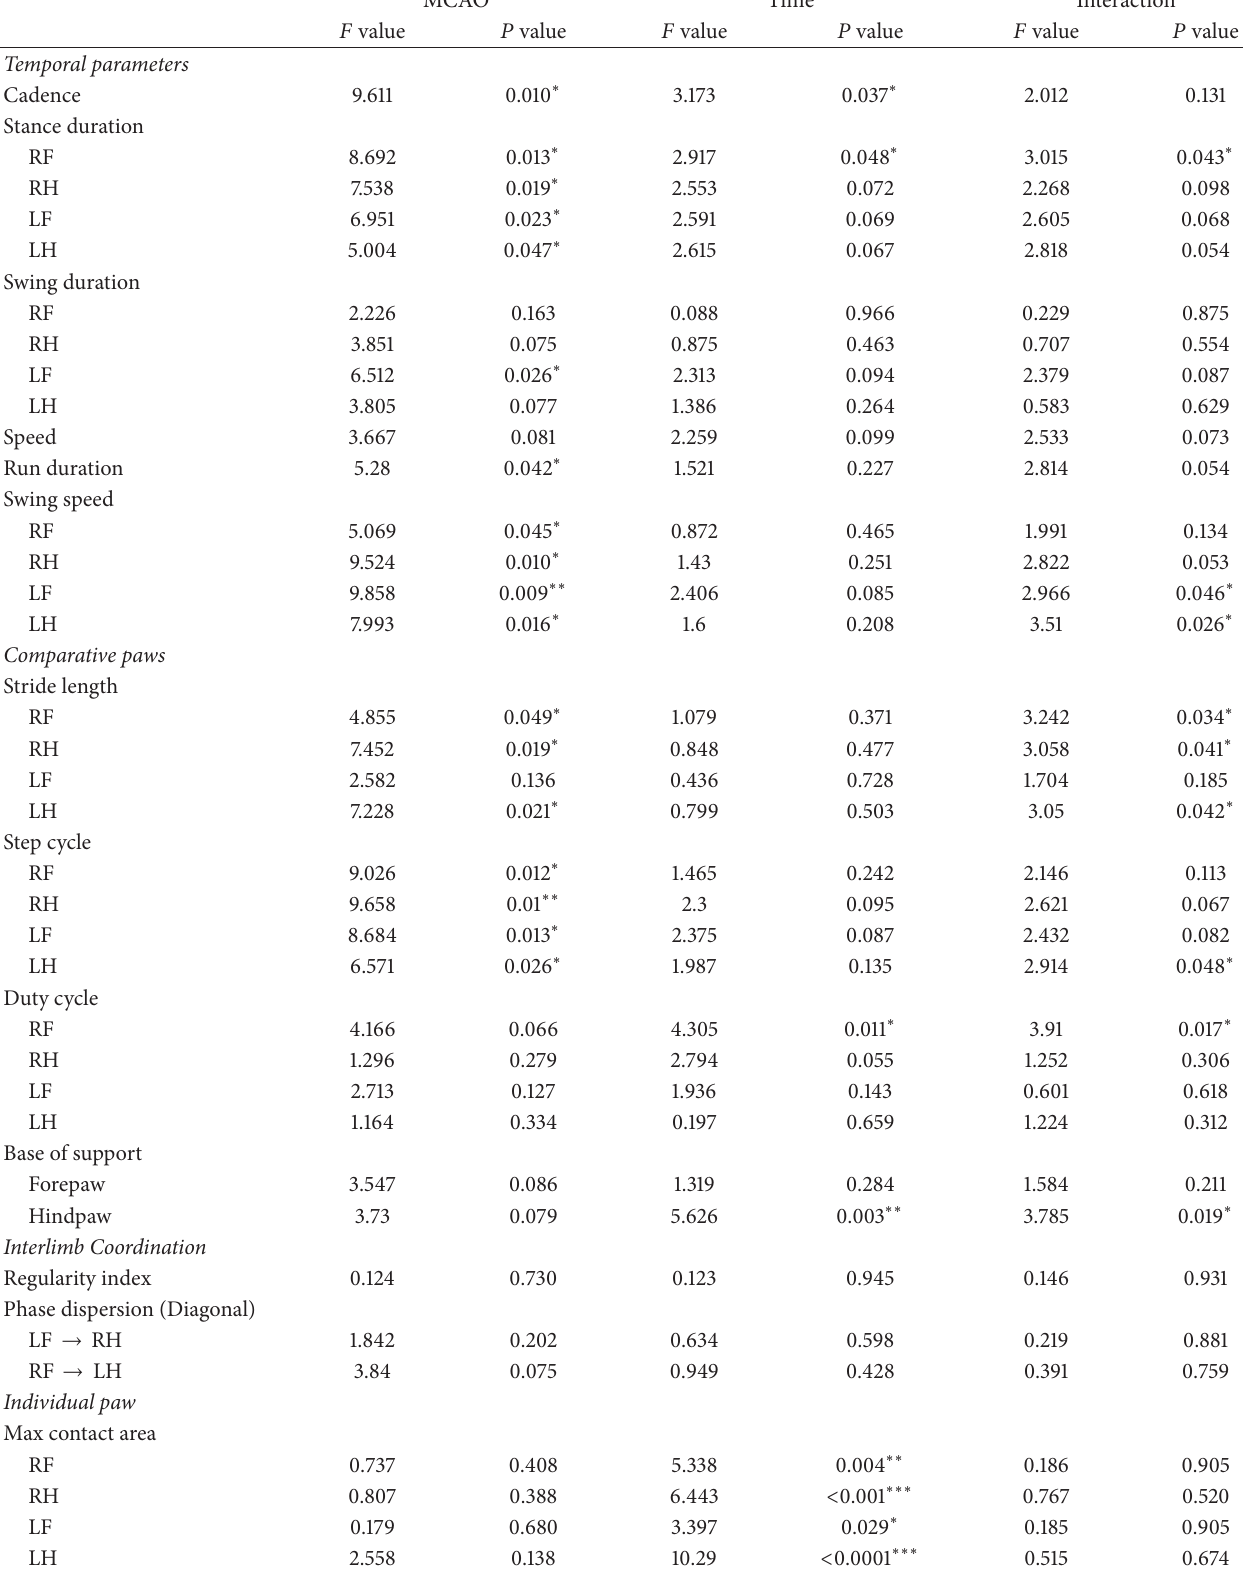
Table 1: CatWalk gait parameter